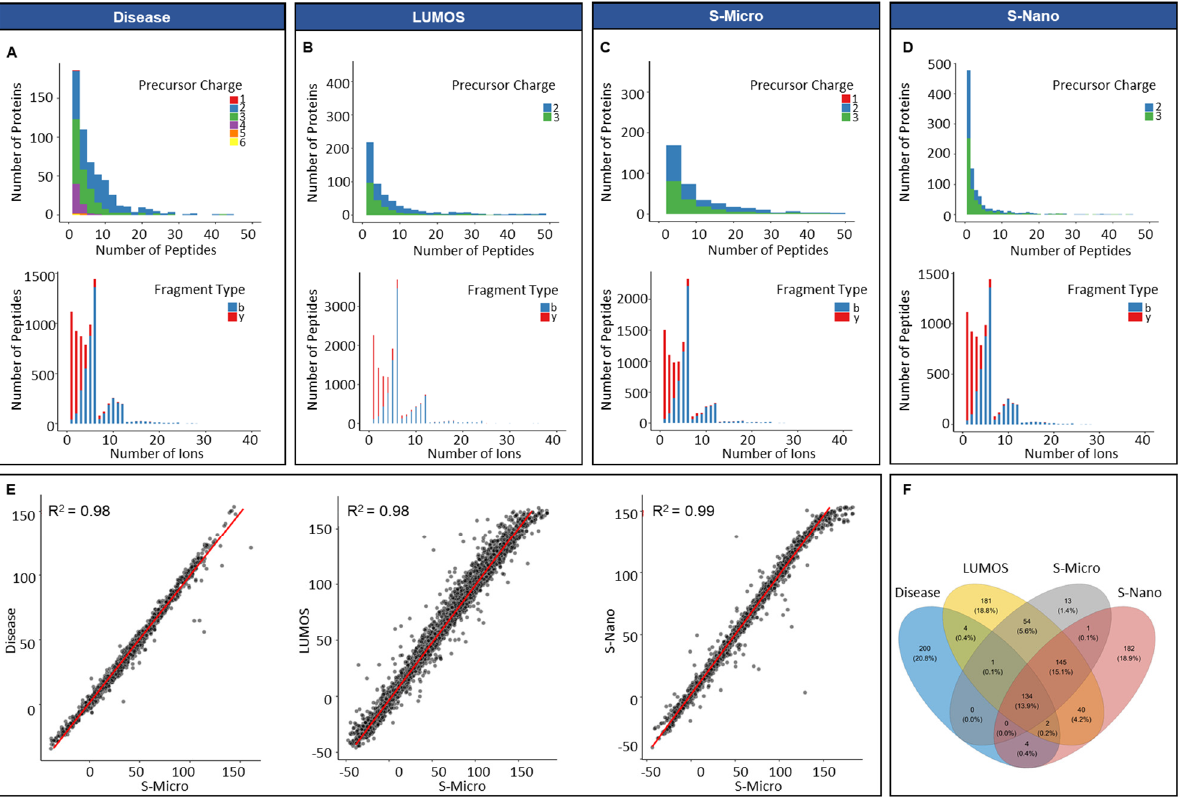
Figure 2. Overview of PCa spectral libraries generated in silico and built in-house. Frequency distribution of peptides per protein and ion per peptides of ( A ) in silico library (Disease); ( B ) in-house library built on Orbitrap Fusion Lumos Tribrid Thermo Scientific mass spectrometer (in micro-flow mode); ( C ) in-house library built on Sciex TripleTOF 6600 mass spec- trometer (in micro-flow mode, S-Micro); ( D ) in-house library built on Sciex TripleTOF 6600 mass spectrometer (in nano- flow mode, S-Nano); ( E ) retention time (RT) correlation between the four libraries by using S-micro as a base library; ( F ) Venn diagram presenting the proteotypic proteins overlap between the four libraries.